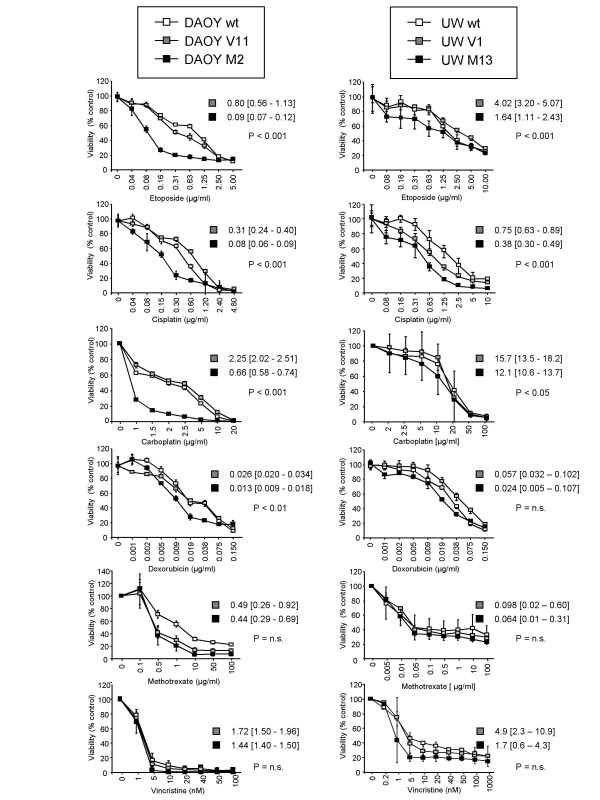
Effect of c-MYC expression on chemo-sensitivity of DAOY and UW228 MB cells. DAOY (c-MYC over-expressing) and to a lesser extent UW228 (c-MYC over-expressing) cells are more susceptible to etoposide, cisplatin, carboplatin, and doxorubicin, and are equally sensitive to methotrexate and vincristine, as determined by MTS assay compared with control cells (DAOY wt, V11; UW228 wt, V1). Values represent the mean percentage of viability (representative from two independent experiments) compared with non-treated cells ± standard deviation (n = 6). The IC50 values and their 95% confidence intervals were calculated from the regression curve and are indicated for each data set for c-MYC- and empty vector-transfected DAOY and UW228 cells. Differences between the two curves are represented by P-values (P < 0.001, P < 0.01, P < 0.05, n.s. not significant).